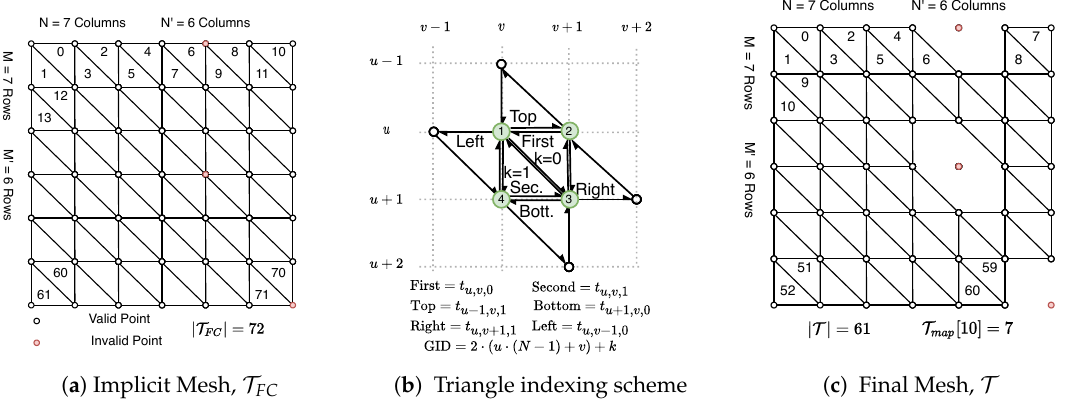
Figure 5. Example conversion of a 7 × 7 Organized Point Cloud (OPC) to a half-edge triangular mesh. Points are represented by circles; red indicates an invalid value (e.g., 0 depth measurement). ( a ) Implicit mesh of OPC with right cut triangles, T FC . A unique global id GID = 2 · ( u · ( N − 1 ) + v ) + k is shown inside each triangle; ( b ) Indexing scheme to define GID s for triangles in T FC ; ( c ) Final mesh T with triangles created if and only if all vertices are valid. Unique indices into T are marked. T map maps between GID s in T FC to T